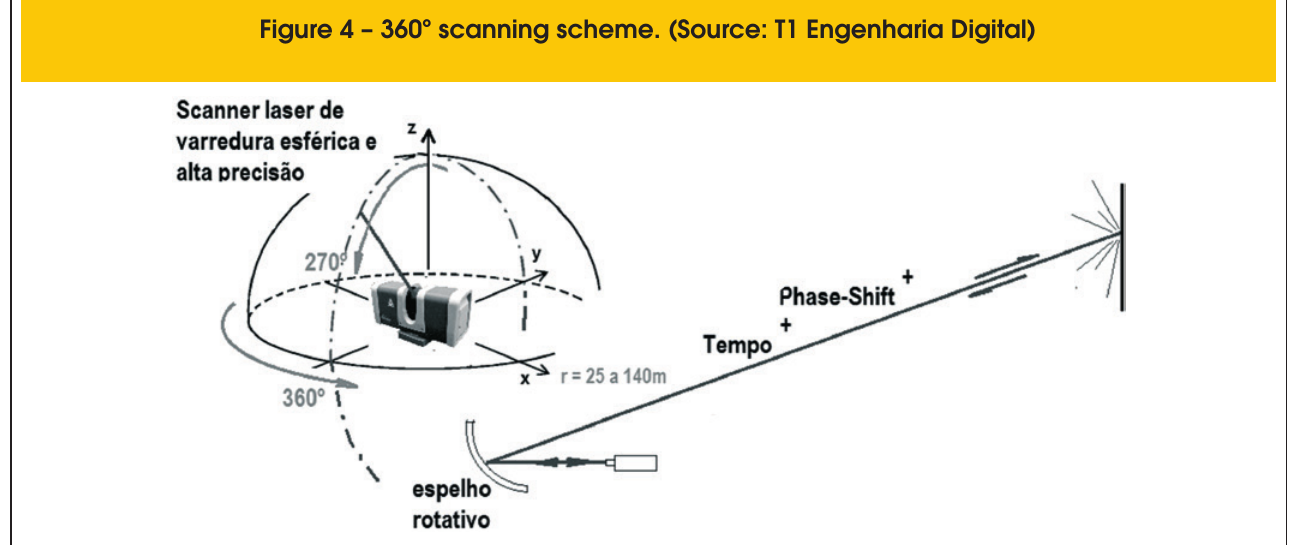
Figure 4 – 360º scanning scheme. (Source: T1 Engenharia Digital)